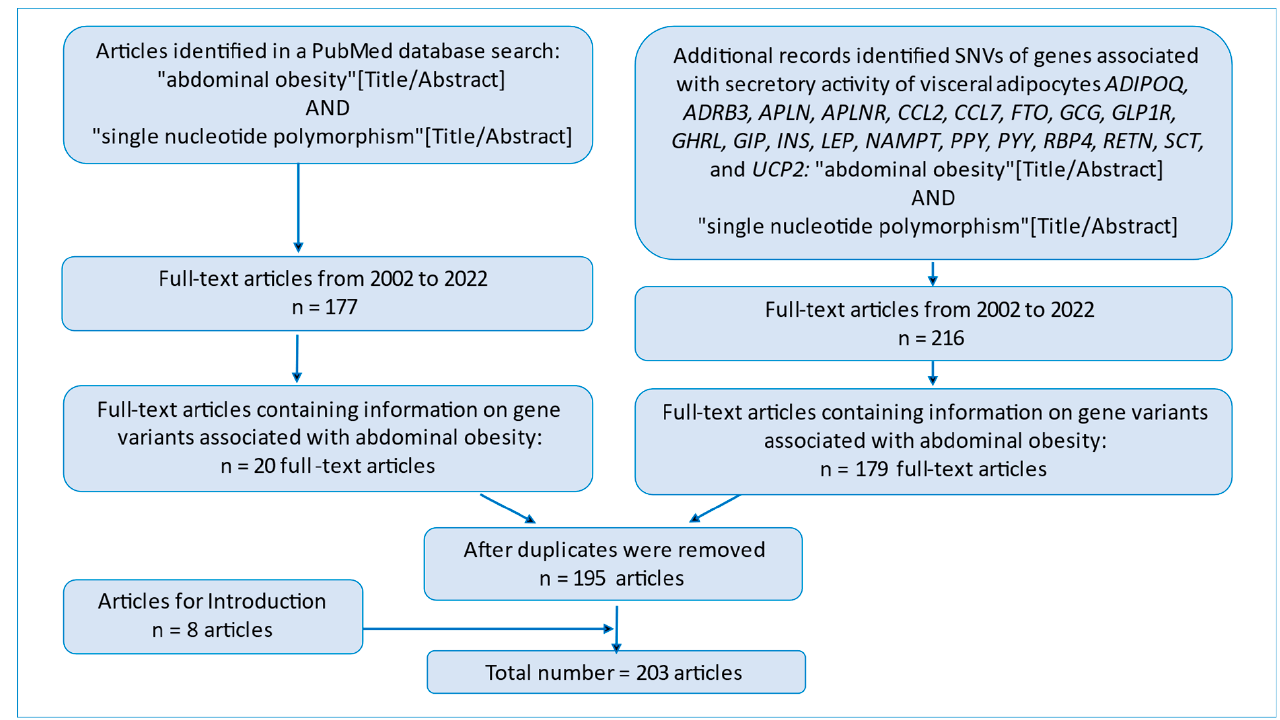
Figure 1. A flowchart of the initial publications in